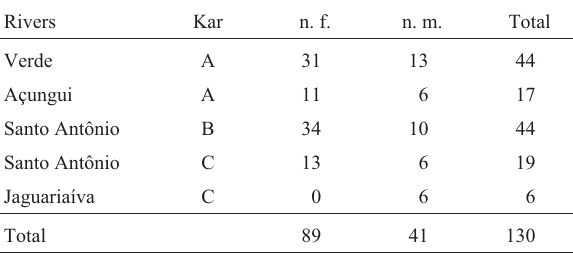
Table 1 - Number of Astyanax samples with the karyotypic forms A, B, and C. Kar = karyotypic forms; n. f . = number of female specimens; n. m. = number of male